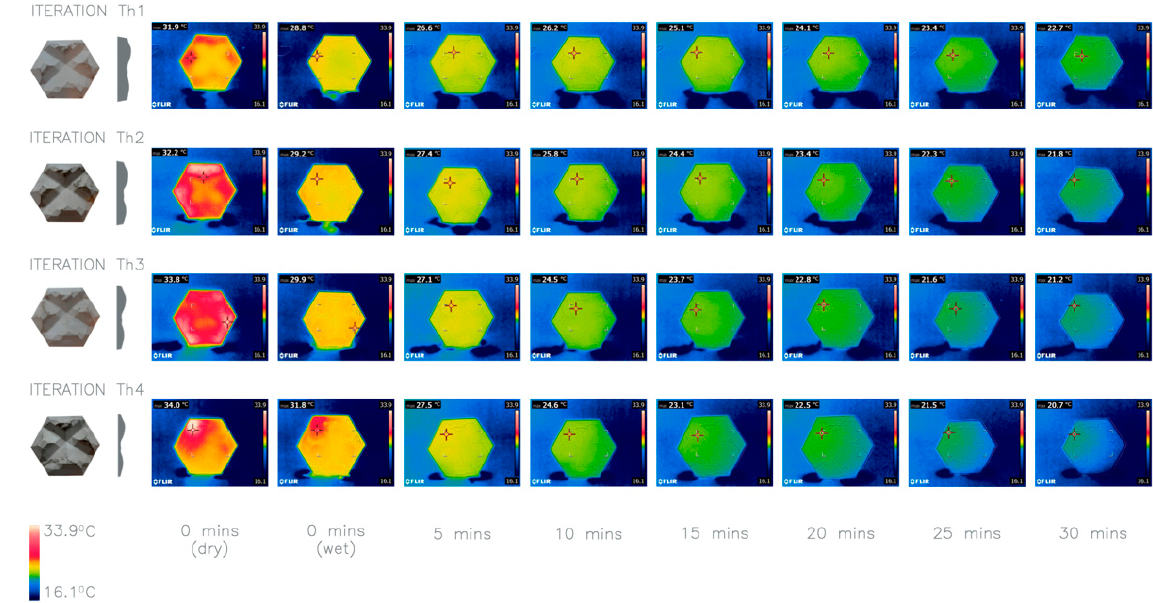
Figure 11. Thermal imaging of investigation 8: comparison of four iterations Th1–4 with different thicknesses. Average heat loss after 30 min: Th1 9.1 °C, Th2 11.73 °C, Th3 13.23 °C, Th4 14 °C.